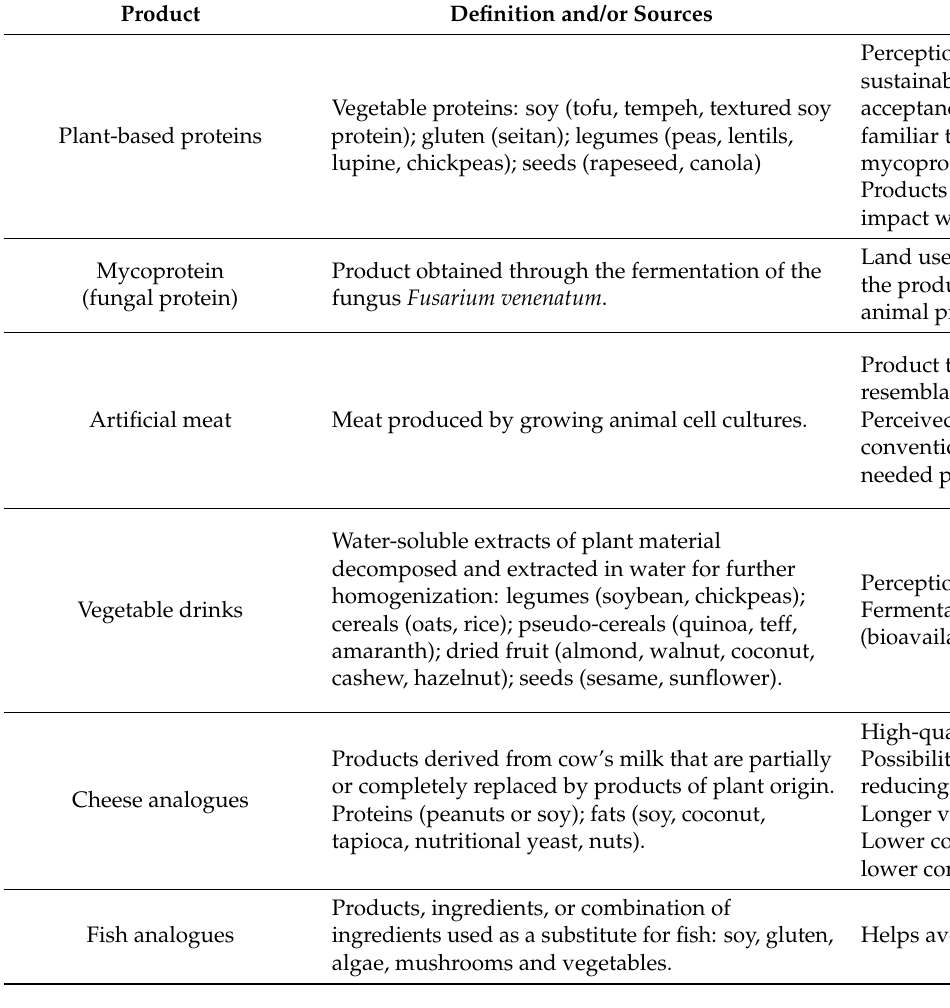
Table 2. Meat alternatives for human consumption (adapted from